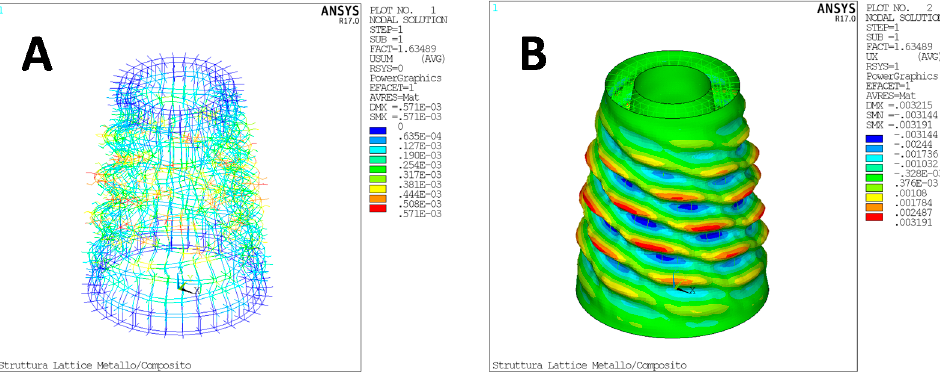
Figure 13. Test case 1—1st buckling mode. ( A ) Total Displacement in Cartesian reference system; ( B ) radial displacement in cylindrical reference system.